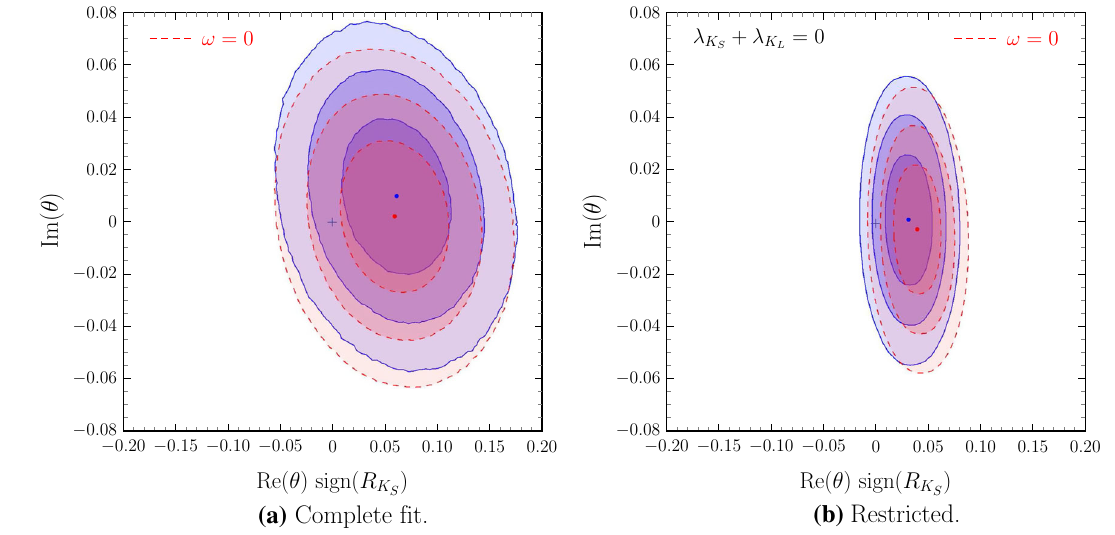
Fig. 2 Comparison of the results with and without ω ; Im (θ) vs. Re (θ) regions are shown in different scenarios: blue regions with solid con- tours correspond to fits including the ω -effect while red regions with